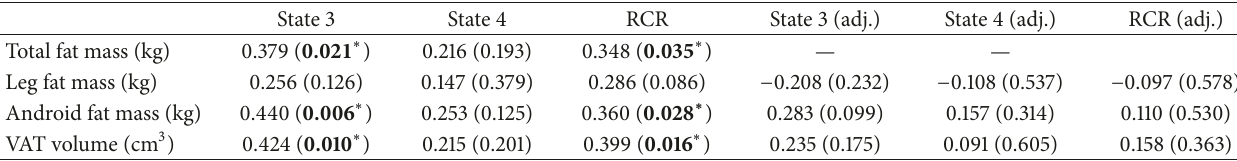
Table 2: Pearson correlation coefficient ( 𝑝 value) and partial correlation coefficient adjust for total fat (kg) ( 𝑝 value). ∗ 𝑝 < 0.05